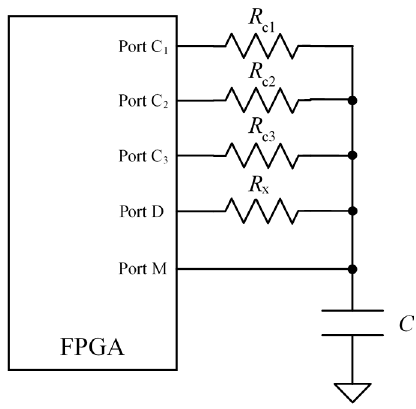
Figure 12. Circuit to implement and compare different calibration techniques.